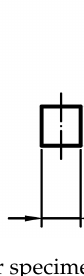
Figure 3. View of cylindrical bar specimens subjected to dynamic compression tests.